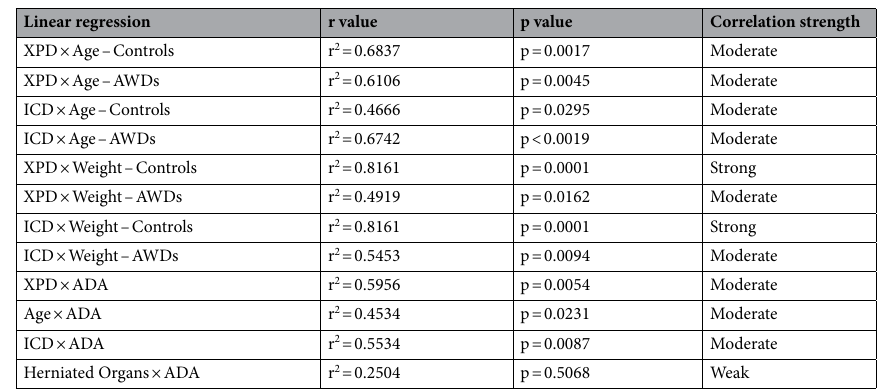
Table 3. The table shows the linear regression analysis (correlation strength: strong, moderate and weak) in the 22 fetuses: 11 with abdominal wall defects (gastroschisis and omphalocele); and 11 without anomalies